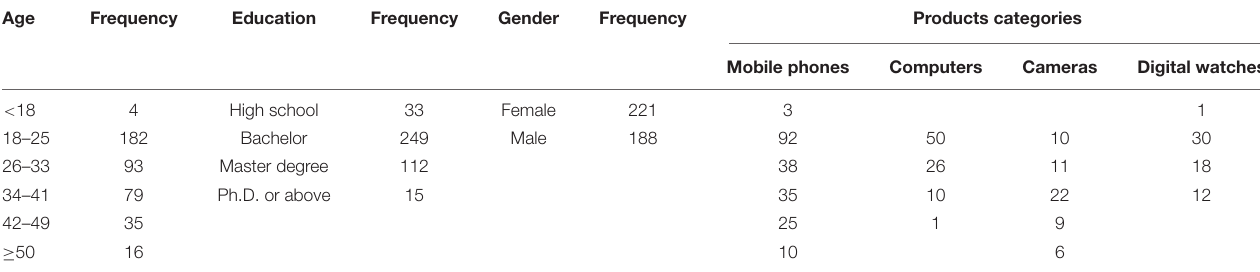
TABLE 1 | Respondents’ demographics and product categories.